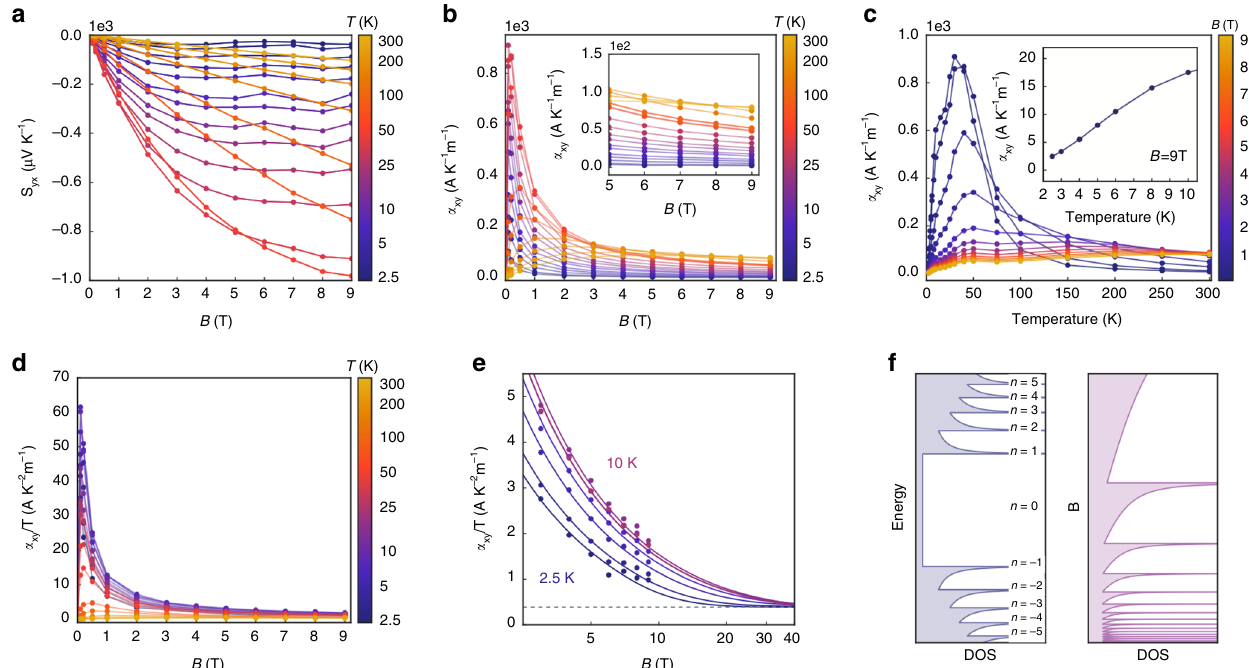
Fig. 3 The quantized thermoelectric Hall effect. a Transverse thermopower S yx as a function of magnetic fi eld at different temperatures. b Thermoelectric Hall conductivity α xy as a function of magnetic fi eld at different temperatures. The peak value is caused by the fi nite scattering effect. c Thermoelectric Hall conductivity α xy as a function of temperature at various fi elds. The inset shows a linear behavior of α xy versus T at low temperatures. d α xy = T as a function of magnetic fi eld at various temperatur e s. e An extrapolation of d showing a convergence to the quantized value at low temperatures. f The density of states (DOS) of each Landau level (LL), highlighting the unique n = 0 LL in a WSM. At high-enough B , n = 0 LL drives the DOS ∝ B .